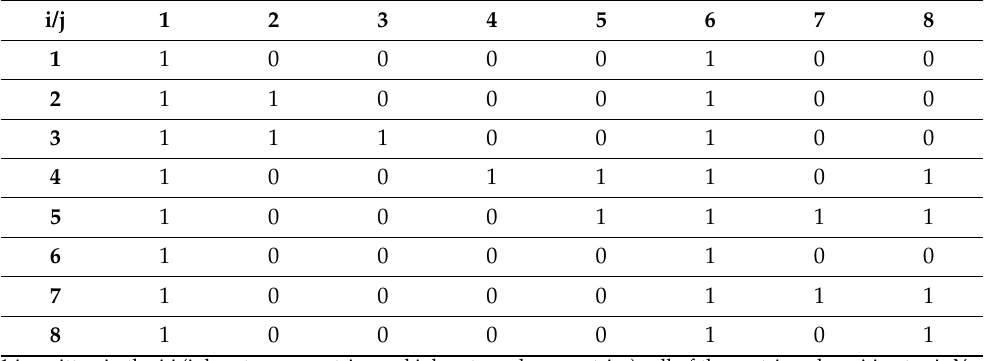
Table 1. Initial Reachable.